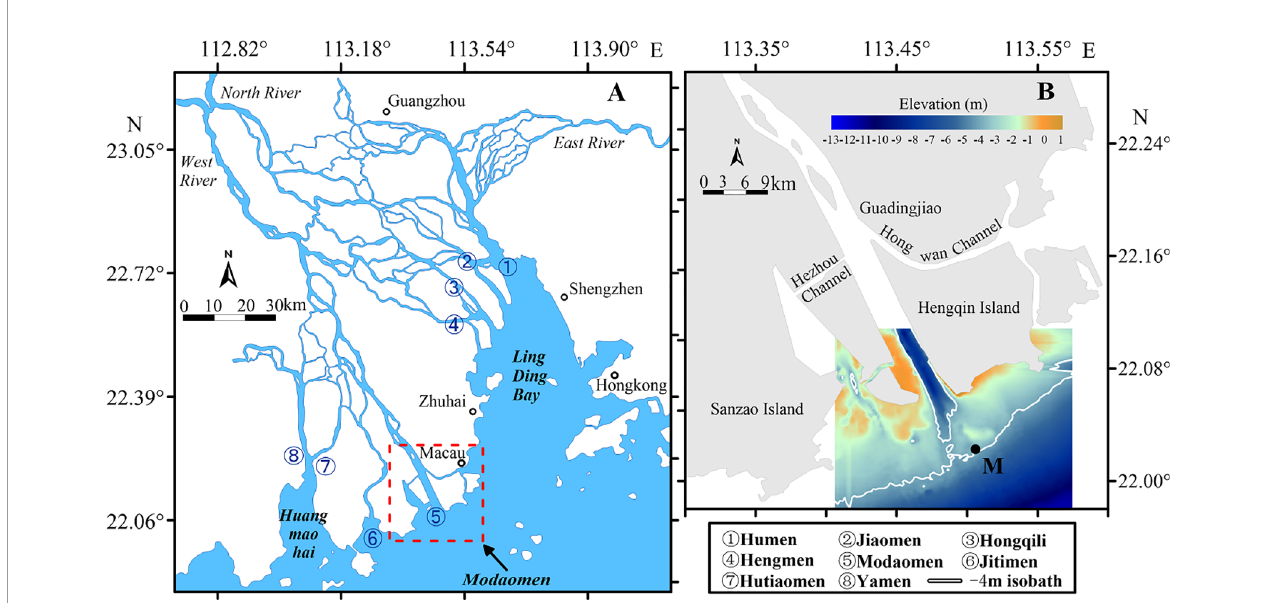
FIGURE 1 | (A) Map of the Pearl River Estuary. (B) Map of the Modaomen Estuary, and the location of measurement site (M) in this